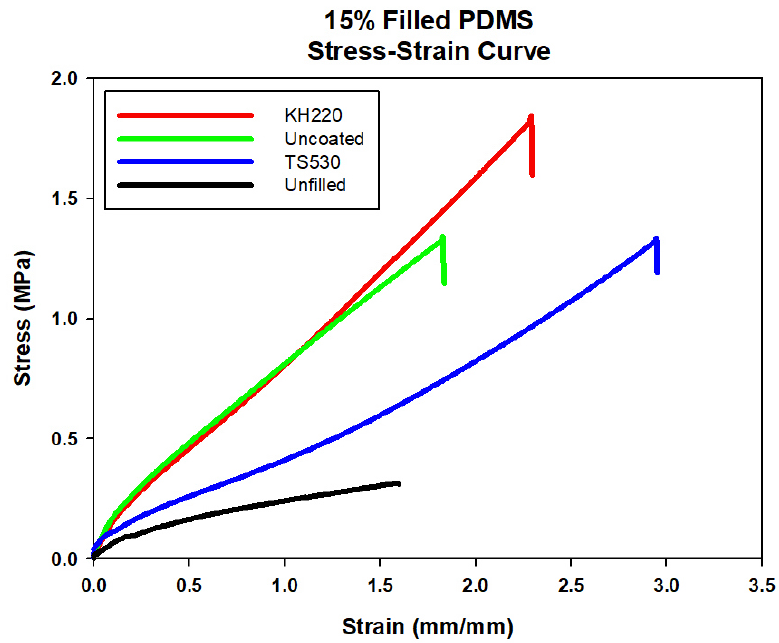
Figure 7. Stress–strain Curve of Unfilled and 15% Filled PDMS with Three Filler Types. Tensile Strength